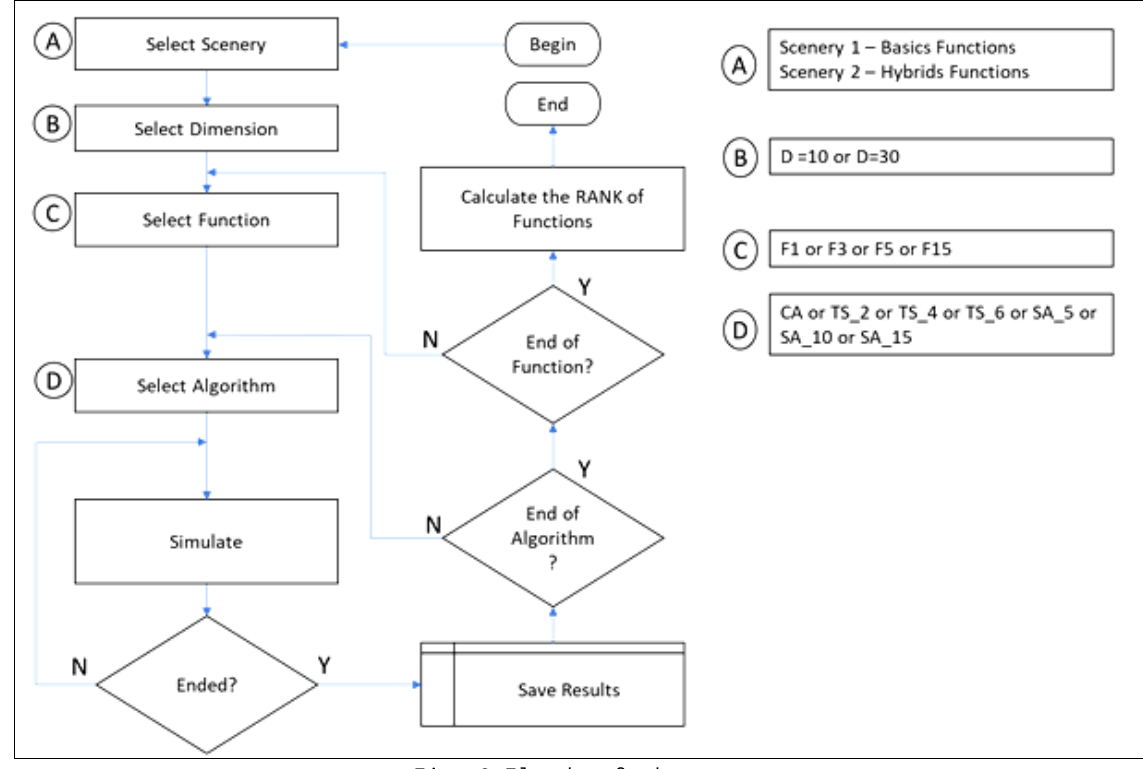
Figure2: Flowchart for the